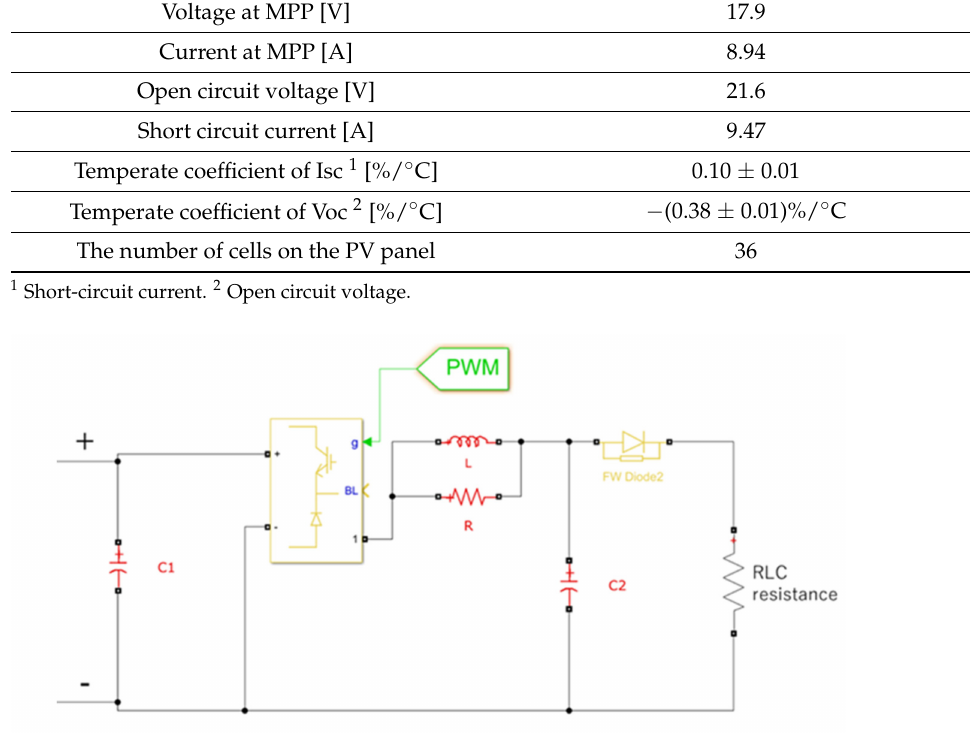
Figure 5. Schematic diagram of the buck converter.